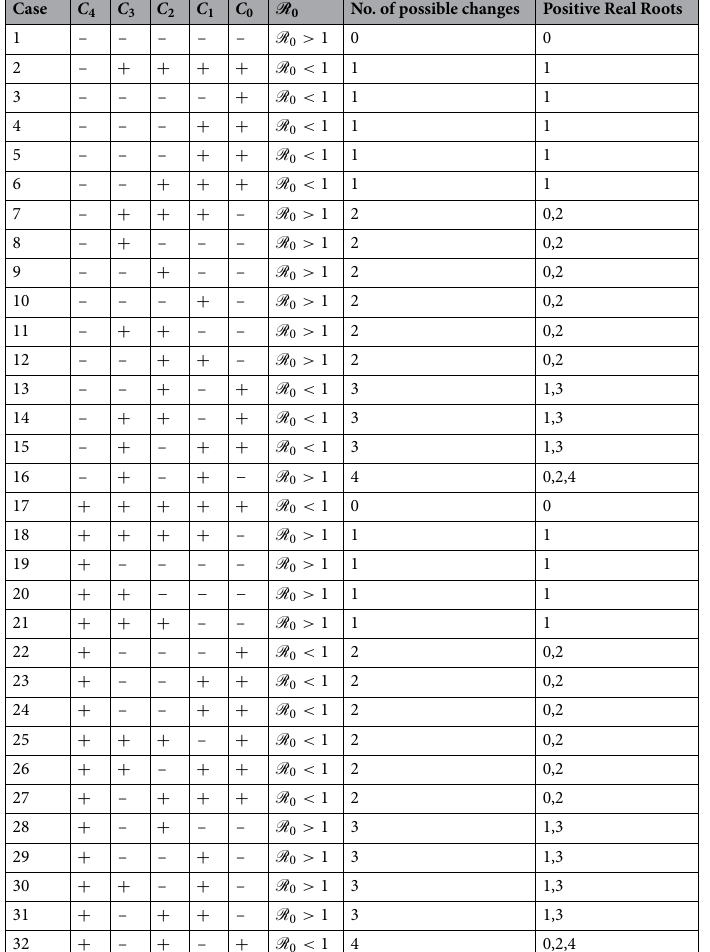
Table 4. Number of possible positive real roots of Eq.